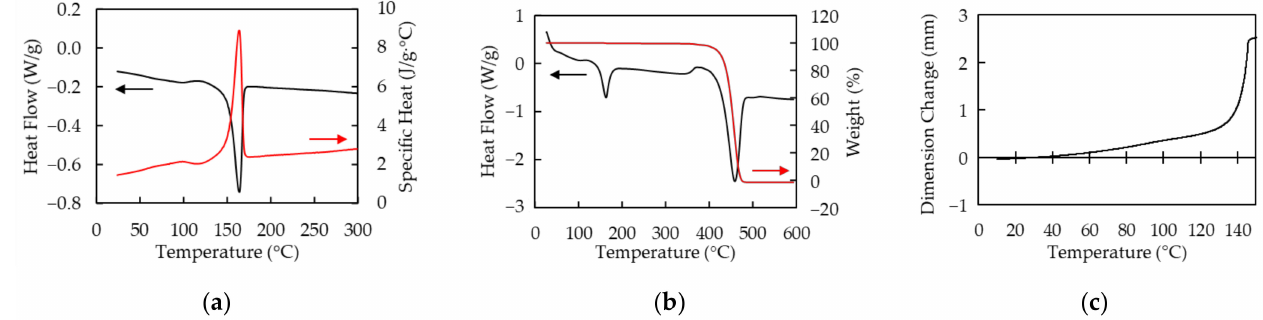
Figure 1. The thermal characteristics of polypropylene (PP) are shown. All measurements are performed under nitrogen atmosphere. ( a ) Heat flow (black line) and specific heat (red line) measured by differential scanning calorimetry (DSC); ( b ) Heat flow (black line) and weight (red line) measured by simultaneous DSC and thermogravimetric analysis (SDT) under nitrogen atmosphere; ( c ) Dimensional change measured by thermal–mechanical analysis (TMA). Static pull force of 0.1 N is applied to a sample.